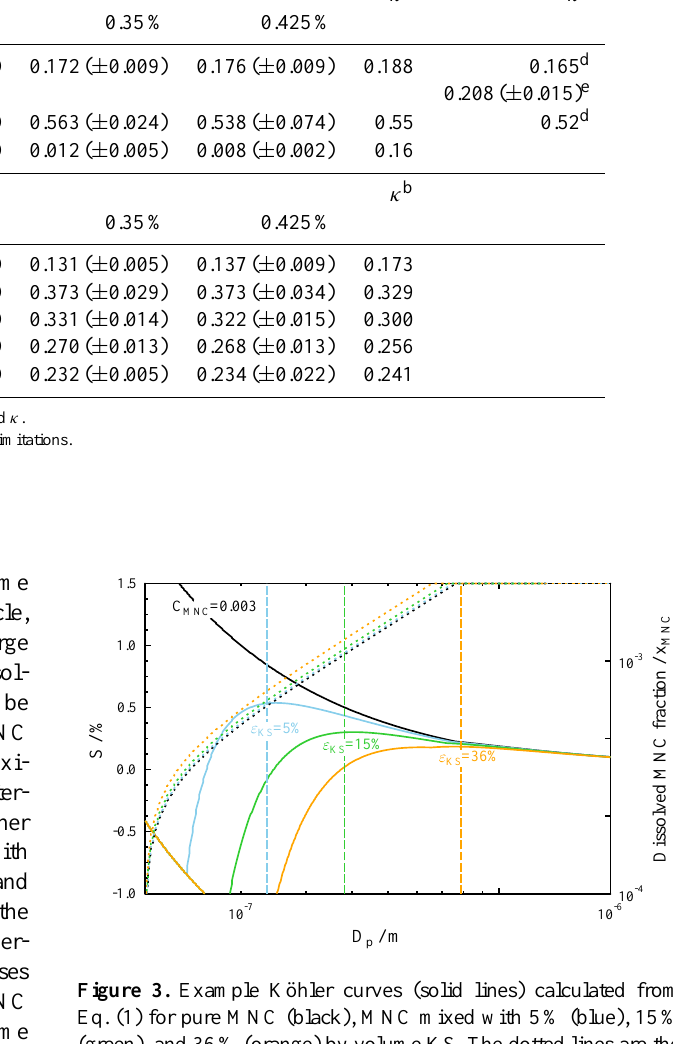
perimentally derived single-component κ ( κ = limit; color- scale symbols), (2) calculated from Köhler theory ( κ = KT; gray-scale symbols), and (3) predicted from Eq. (6), which assumes no solubility limitations (i.e., C = ∞ ; horizontal lines). For all particle mixtures containing equal by mass MNC (i.e., 1 : 1 : 0, 0 : 1 : 1, and 1 : 1 : 1), applying the ex- perimentally derived single-component κ underpredicts the experimentally derived κ of the mixtures. Note that when assuming solubility limitations, κ could not be predicted at S = 0 . 2 % for the mixtures containing MNC since κ